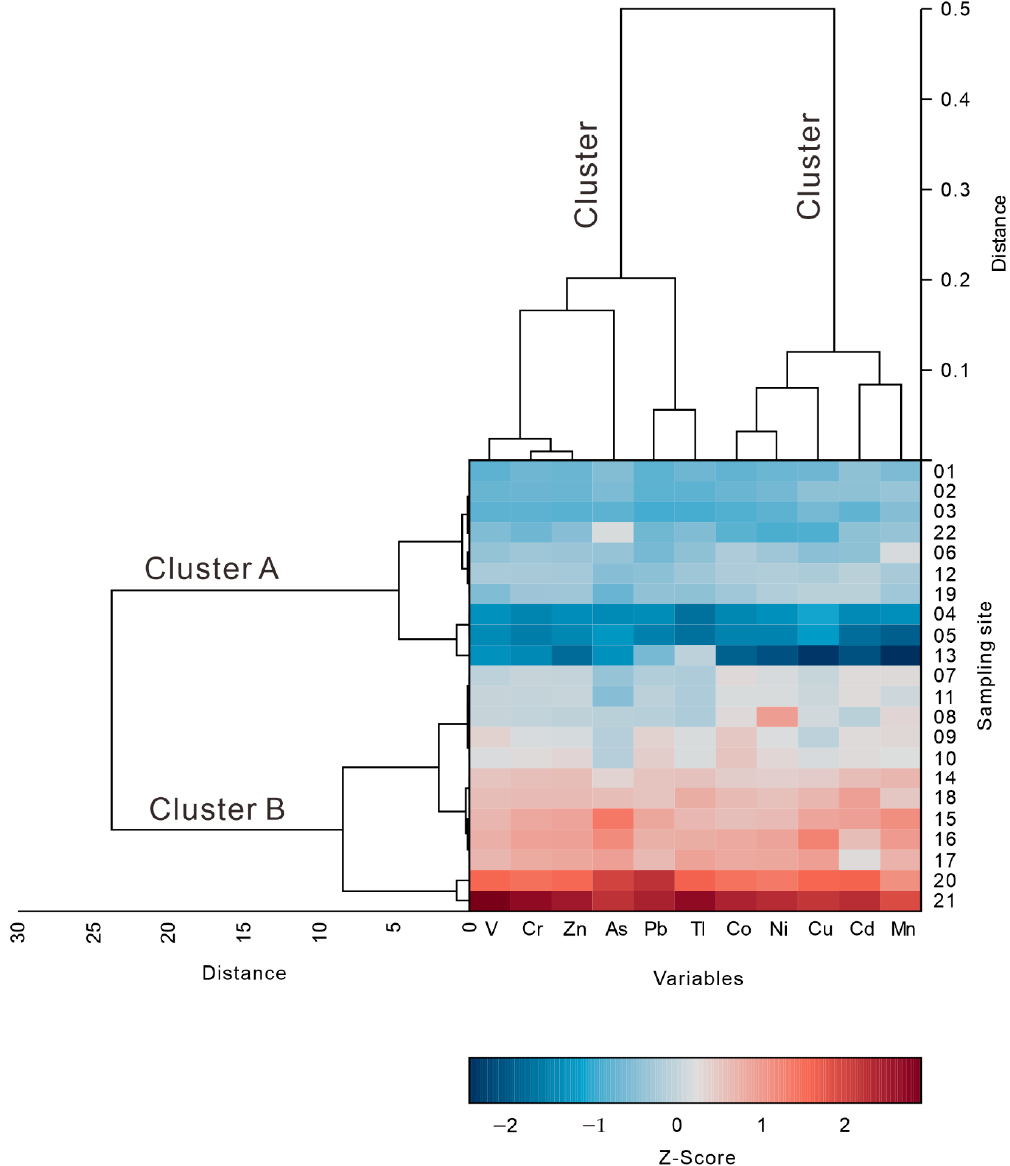
Figure 5. Two-way clustering results for the potentially-toxic elements and sampling sites of the surface sediments.